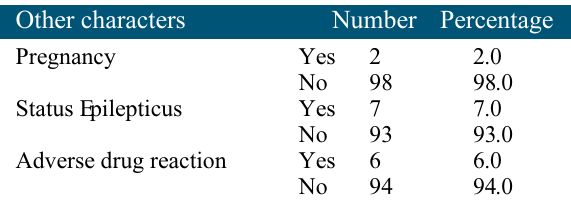
Table 5: Precipitants of seizure